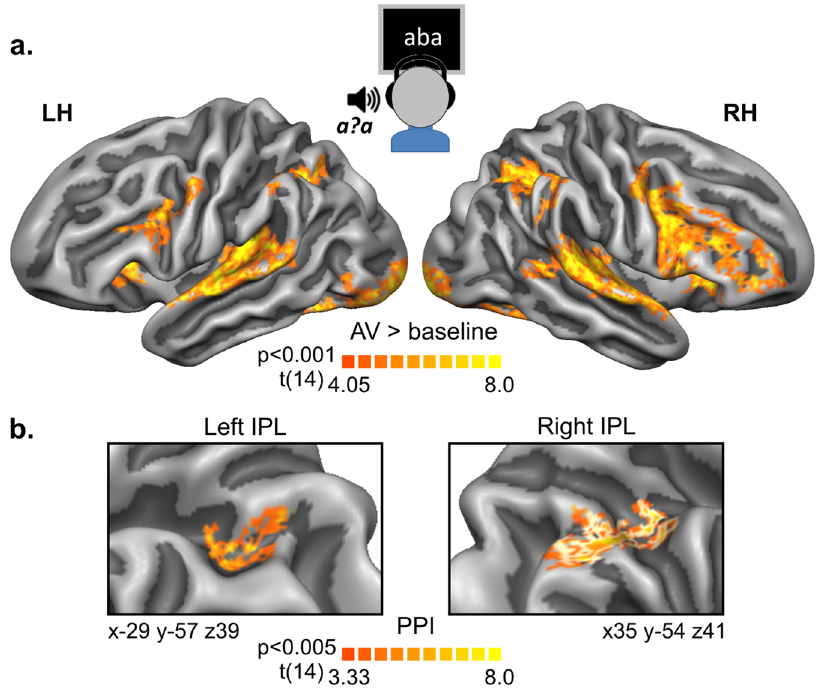
Figure 5. fMRI activity and connectivity during audiovisual exposure blocks. ( a ) Functional contrast maps illustrating overall BOLD responses during the audiovisual (AV) exposure blocks, corrected for multiple comparisons using cluster size correction (p corr < 0.05) with a primary threshold of p vertex = 0.001. ( b ) Psychophysiological interaction (PPI) maps during the AV exposure blocks showing significant clusters in the left and right inferior parietal lobe (IPL) with normalized areas of 58 and 181 mm 2 respectively. Talairach coordinates (xyz) refer to the centre of gravity of the IPL regions. Maps are corrected for multiple comparisons using cluster size correction (p corr < 0.05) with a primary threshold of p vertex = 0.005. At a primary threshold of p vertex = 0.001 only the right IPL cluster survives (white outlines). All maps are based on random effects contrasts and visualized on group-averaged and aligned cortical surface representations of the left (LH) and right (RH)